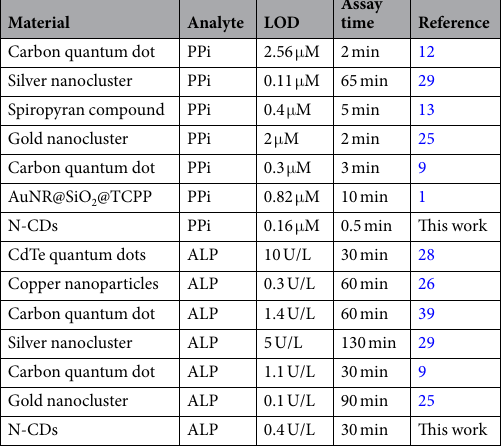
Table 1. Comparison of sensitivity and assay time of our assay with other fluorescent methods for PPi and ALP activity